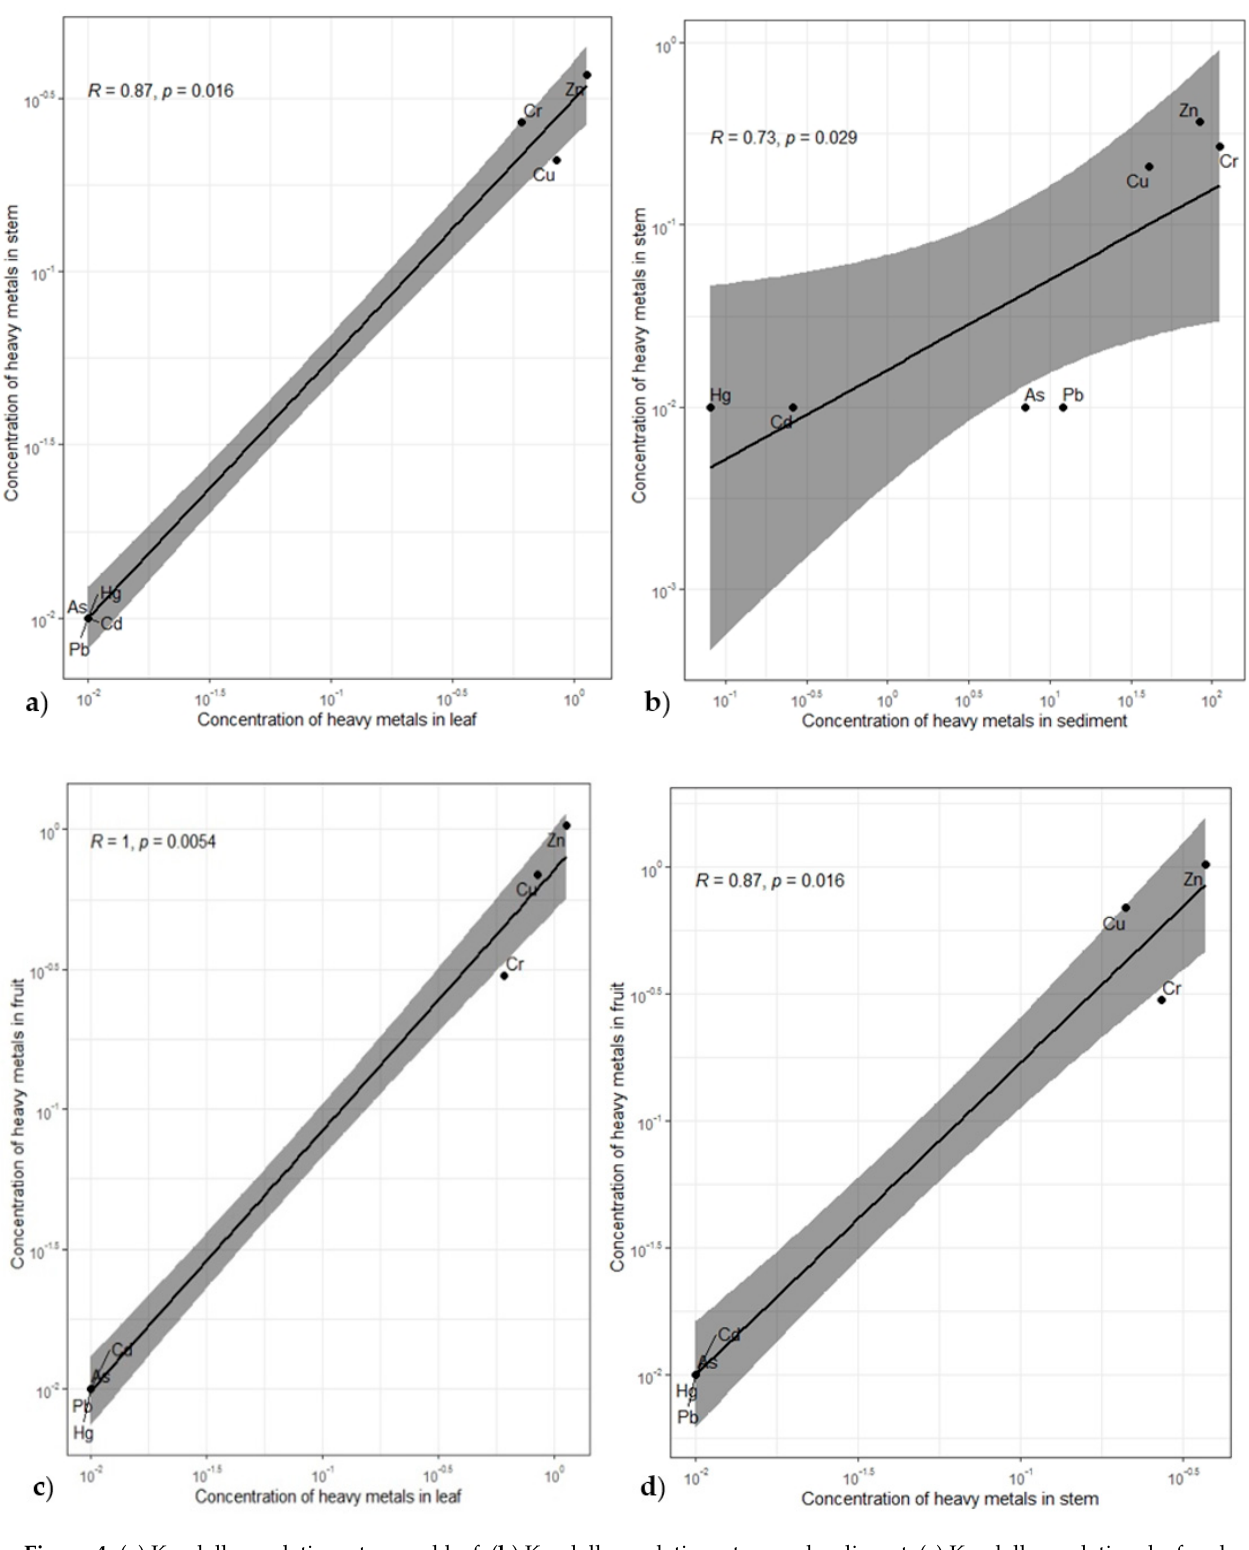
Figure 4. ( a ) Kendall correlation, stem and leaf; ( b ) Kendall correlation, stem and sediment; ( c ) Kendall correlation, leaf and fruit; ( d ) Kendall correlation, stem and fruit.